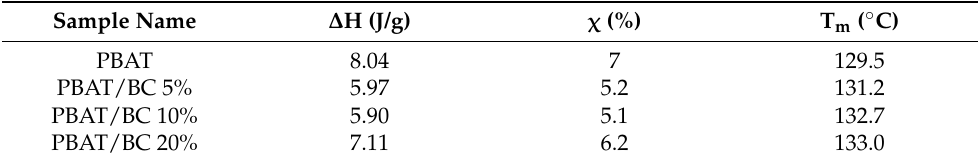
Table 1. Thermal properties collected during the second heating scan for all investigated systems.